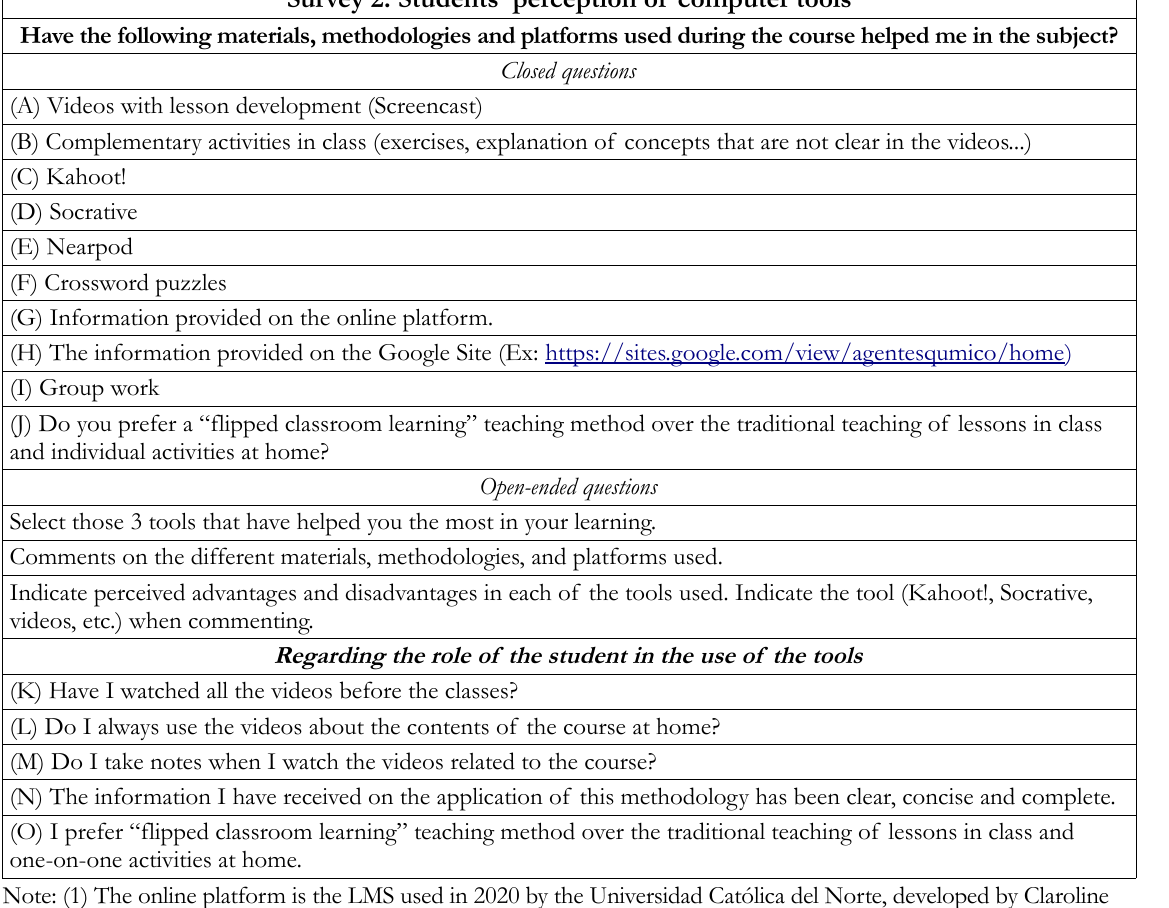
Table 3. Dimensions analyzed in survey 2 (Salcide-Talledo et al.,